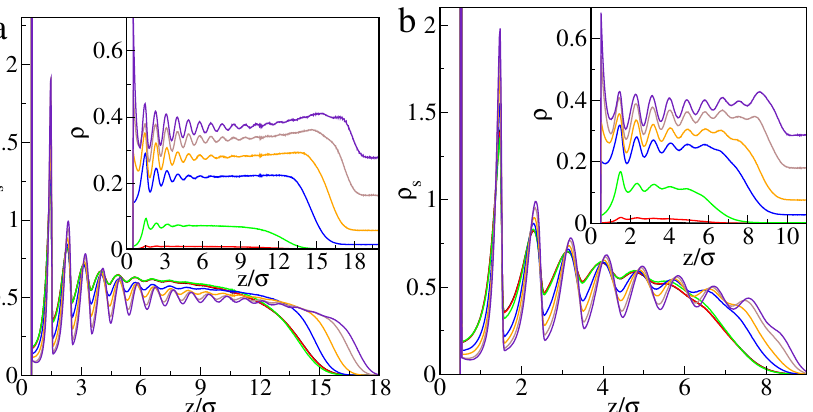
Figure 5. Density profiles of the chain segments and fluid particles (insets) near the flat substrate for the model M1 and different chain lengths: ( a ) M = 20, ( b ) M = 10 plotted for different initial densities of the fluid ρ 0 = 0.0001 (black), 0.001 (red), 0.01 (green), 0.05 (blue), 0.1 (yellow), 0.2 (brown), and 0.3 (violet). Other parameters: f = 20, ε Ps = 1.5 ε